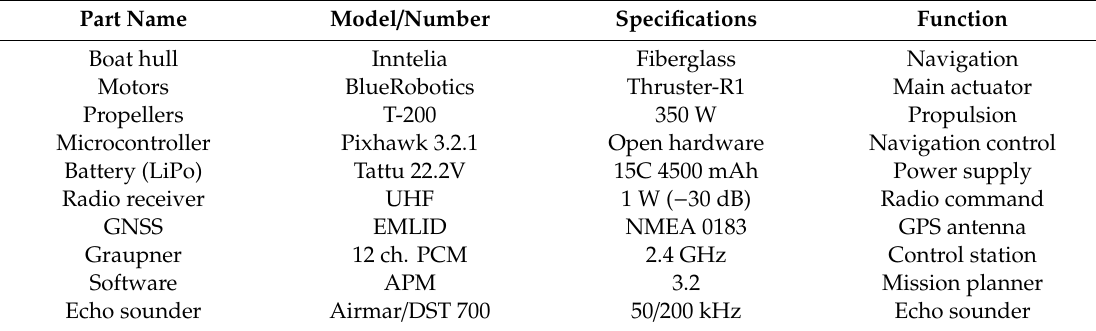
Table 3. Specifications of the Unmanned Surface Vehicle (USV) components